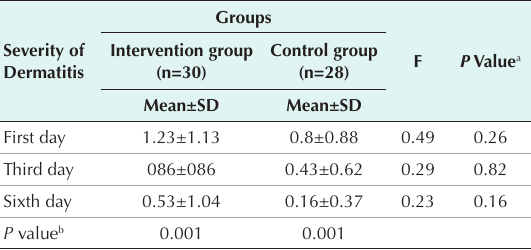
Table 2. Comparison of the Severity of Diaper Dermatitis on 1st, 3rd and 6th Days of Intervention in the Control and Intervention Groups Groups Severity of Dermatitis